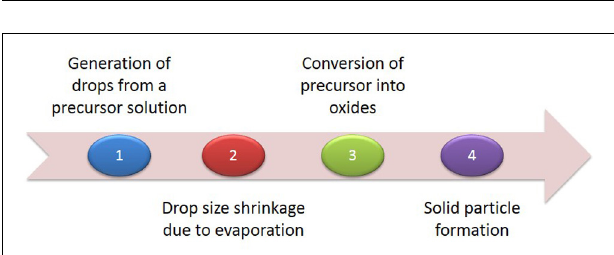
FIGURE 3 | The top–down and bottom–up approaches for AuNPs synthesis.